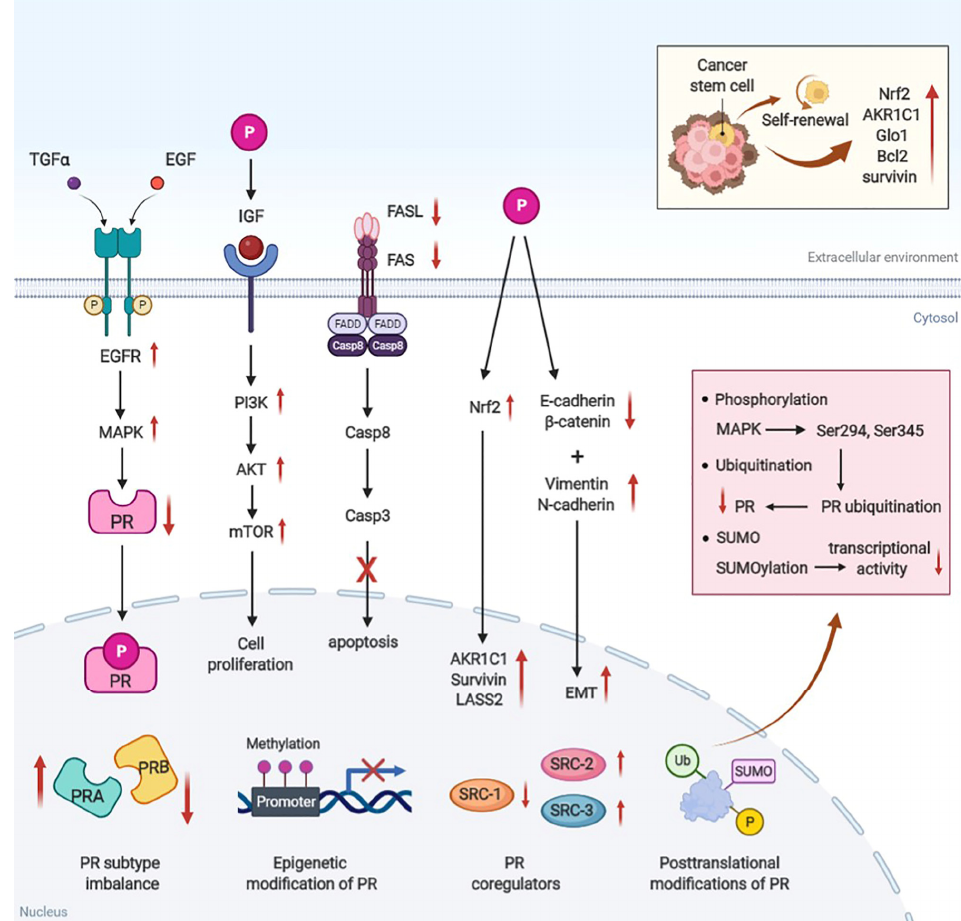
Figure 2. Mechanism of progestin resistance related to PR signal pathway. The mechanisms of PR